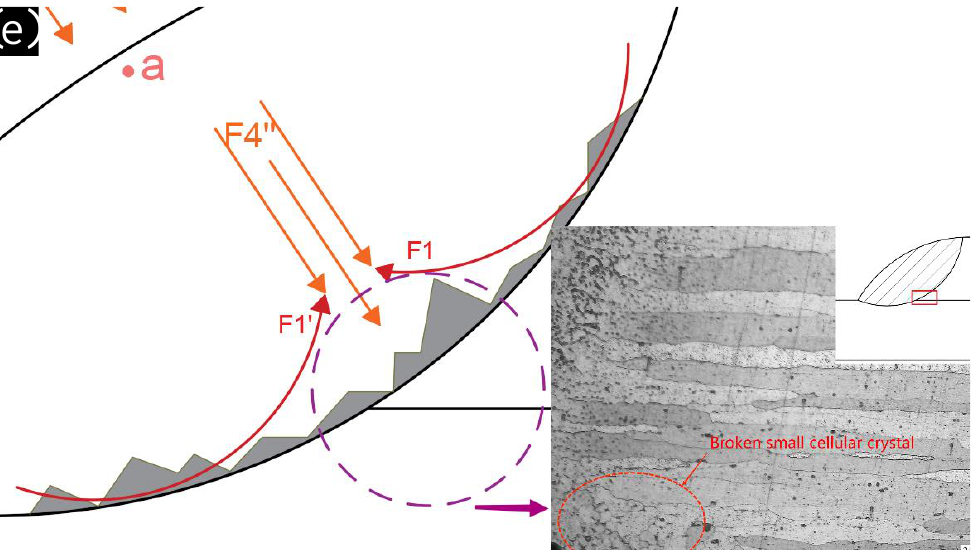
Figure 3. Stress analysis of the broken grains: ( a ) weld pool of the lap joint, ( b ) collapse morphology, ( c ) upper right corner of the fusion line, ( d ) lower left corner of the fusion line, ( e ) weld bottom of the fusion line, ( f ) other positions of the fusion line.